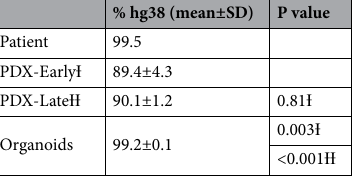
Table 1. PDXs and organoids human sequence match by